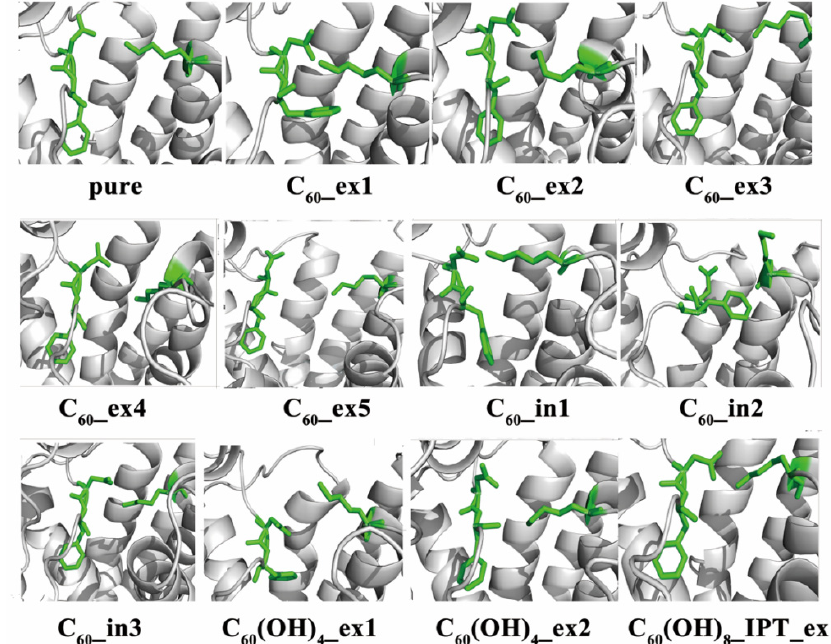
Figure 12. The conformations of PHE193 in snapshots at the final 1ns.